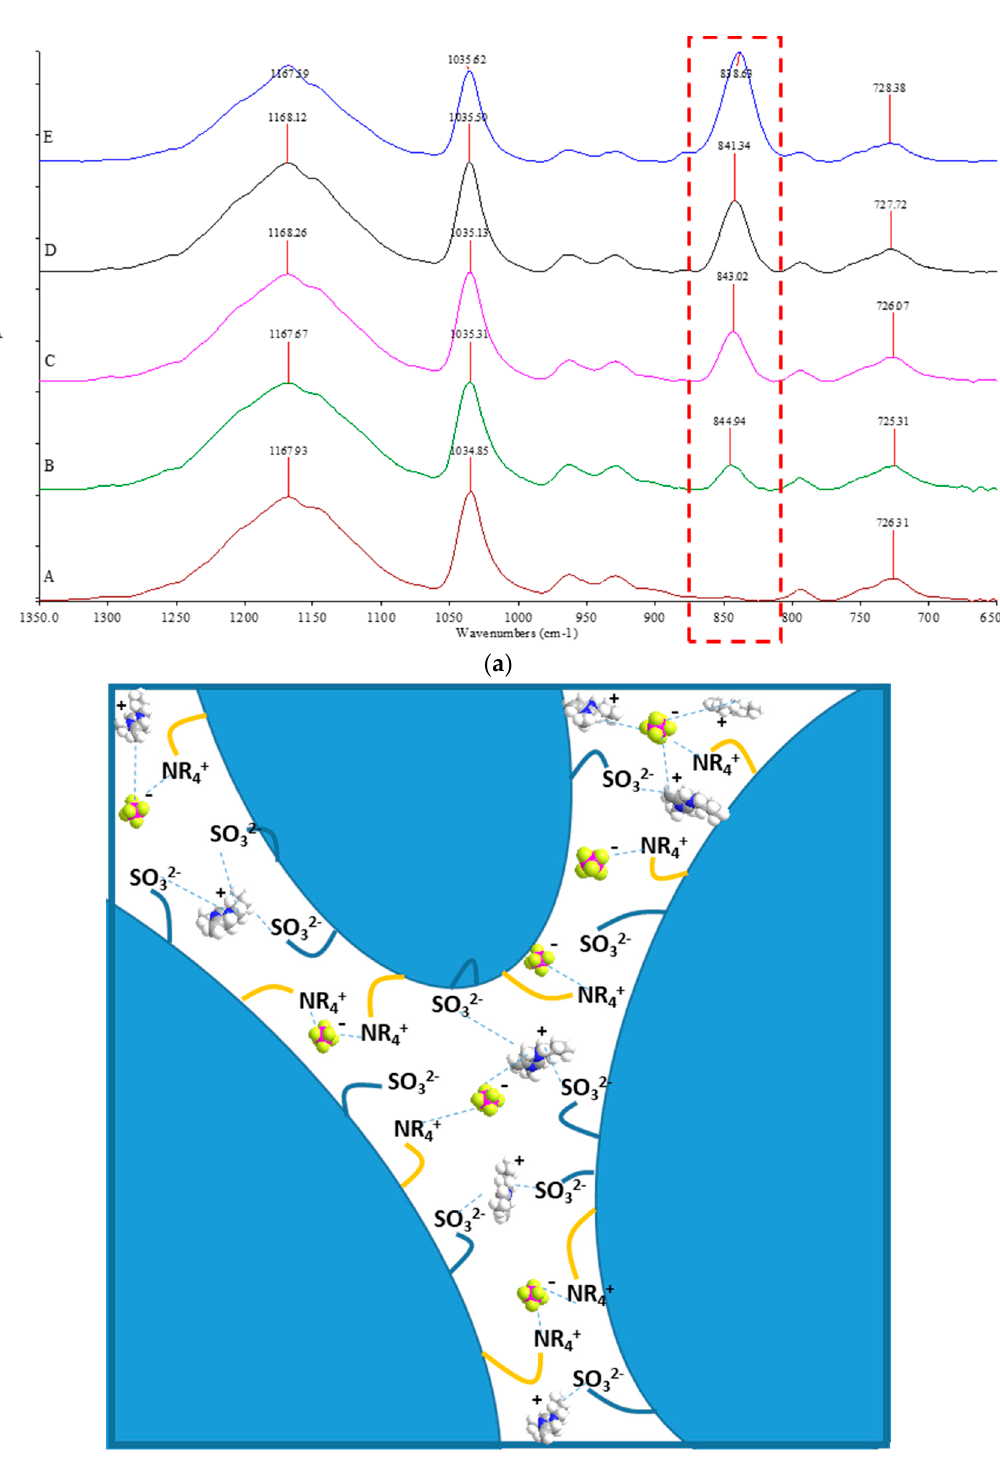
Figure 4. ( a ) ATR-FTIR spectra of ionic liquid hydrogel composite membranes (IL-HCMs) prepared with an increasing amount of IL (see Table 1): (A) SPE, (B) SPE-IL1%, (C) SPE-IL5%, (D) SPE-IL10%, (E) SPE-IL15%. ( b ) Schematic illustrating the effect of interaction between the fixed polyelectrolyte charges and mobile ionic liquid charges. White region denotes the hydrogel mesh structure with polymer chains and cross-linking points, blue spaces represent voids. The polymer mesh structure drawn here does not necessarily represent the effective system. The size of the ions relative to the mesh size is not drawn to scale.